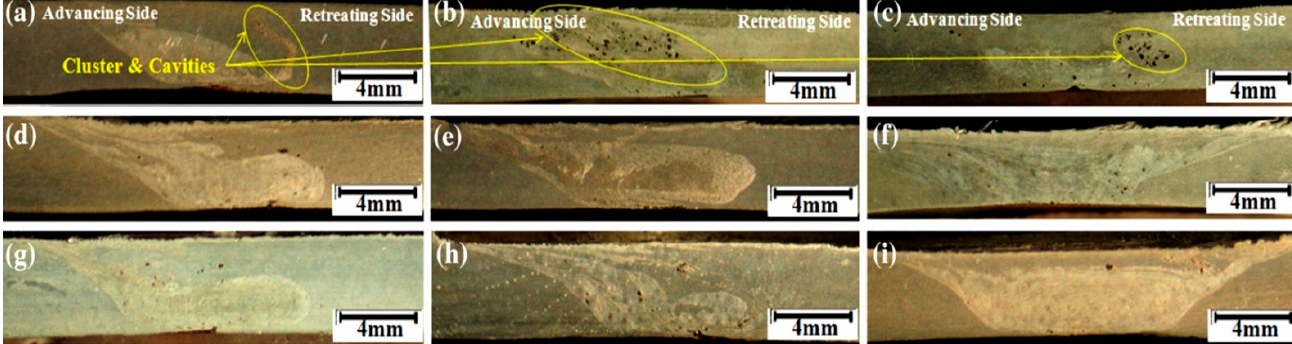
Figure 18. Cross-section of joints obtained at: ( a ) 800 rpm-F pass; ( b ) 800 rpm-2F passes; ( c ) 800 rpm- FB passes; ( d ) 1000 rpm-F pass; ( e ) 1000 rpm-2F passes; ( f ) 1000 rpm-FB passes; ( g ) 1200 rpm-F pass; ( h ) 1200 rpm-2F passes; ( i ) 1200 rpm-FB passes [56]. Reprinted from: The effect of Cu powder during